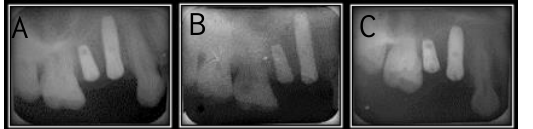
Figure 7: Three postoperative periapical radiograph taken at: A- immediately after surgery, B- at 8 weeks, C- at 16 weeks.